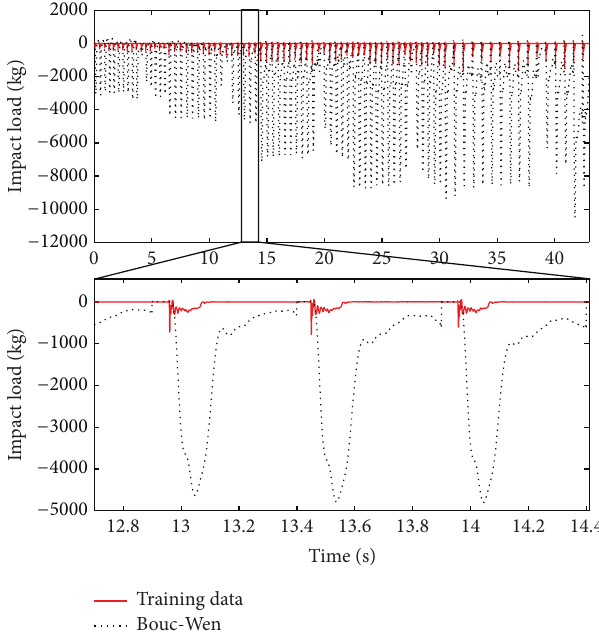
Figure 12: Comparison of the impact load measurements with the Bouc-Wen model for various currents and drop release heights.